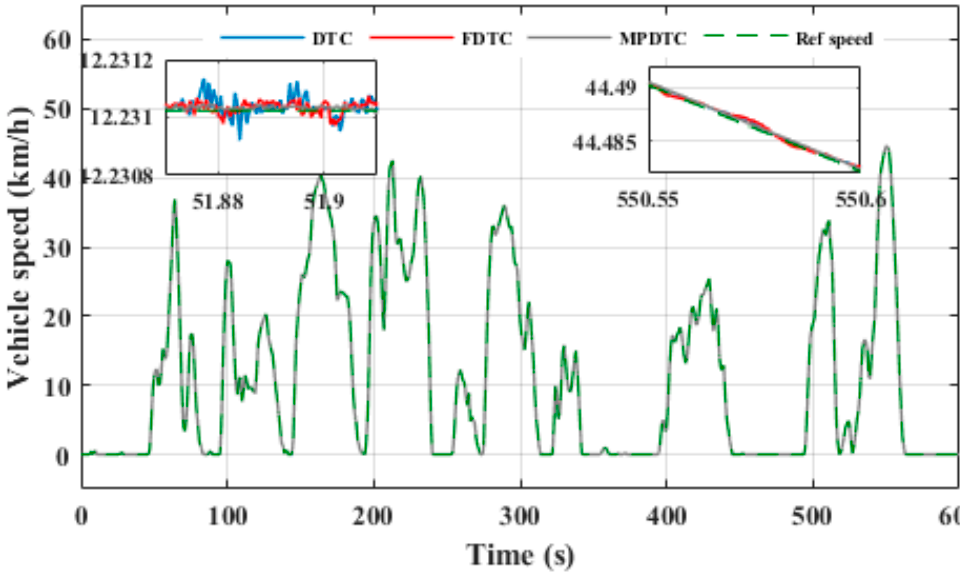
Figure 14. Electric vehicle speed under different control techniques with NYCC driving cycle.